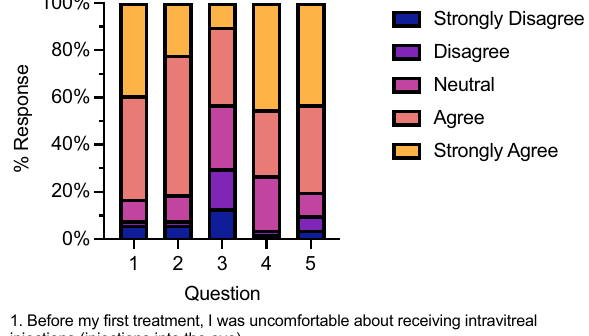
Figure 1. Opinions on IVT therapy expressed as a 100% stacked column chart of Likert-scaled responses from survey questions. n = 52–54 responses as in Table 2.